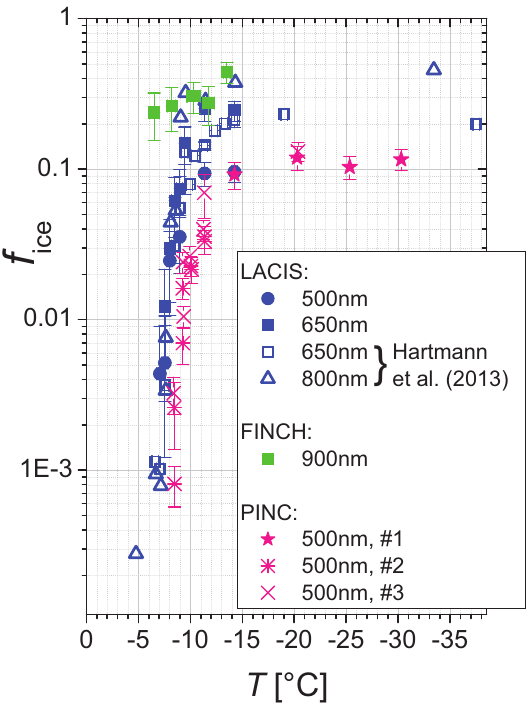
Figure 7. Frozen fractions as a function of temperature measured with FINCH, LACIS and PINC for different dry particle sizes. Open symbols given for LACIS represent the data published in Hartmann et al. (2013). PINC data labeled with #1 were taken during a cam- paign at LACIS, #2 and #3 denote data taken at ETH using the INUIT snomax sample and a different Snomax sample,